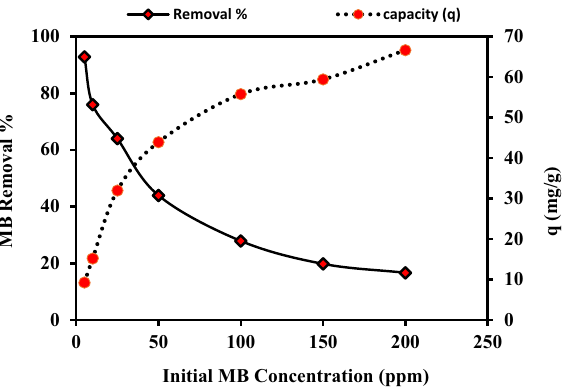
Figure 3. Effect of initial MB concentration on its biosorption by the biomass of P. alcaliphila